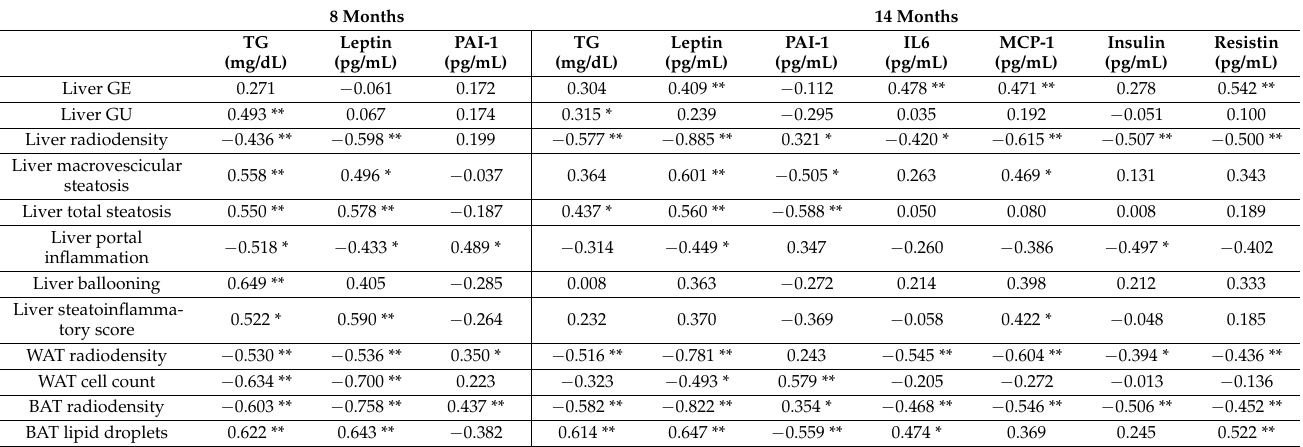
Table 2. Correlations between circulating markers and tissue structure and functional